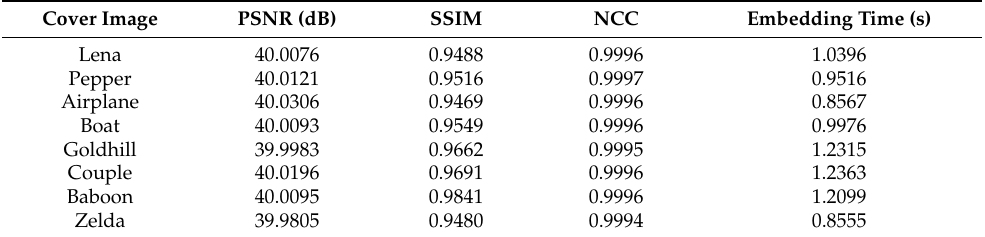
Table 4. Measuring PSNR, SSIM, NCC and time (second) of marked images based on the proposed